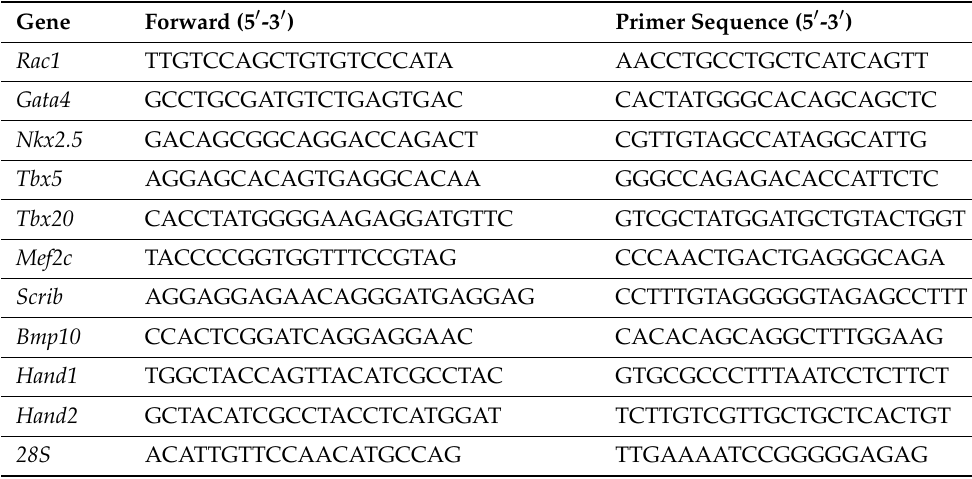
Table 2. Primer sequences for real time RT-PCR